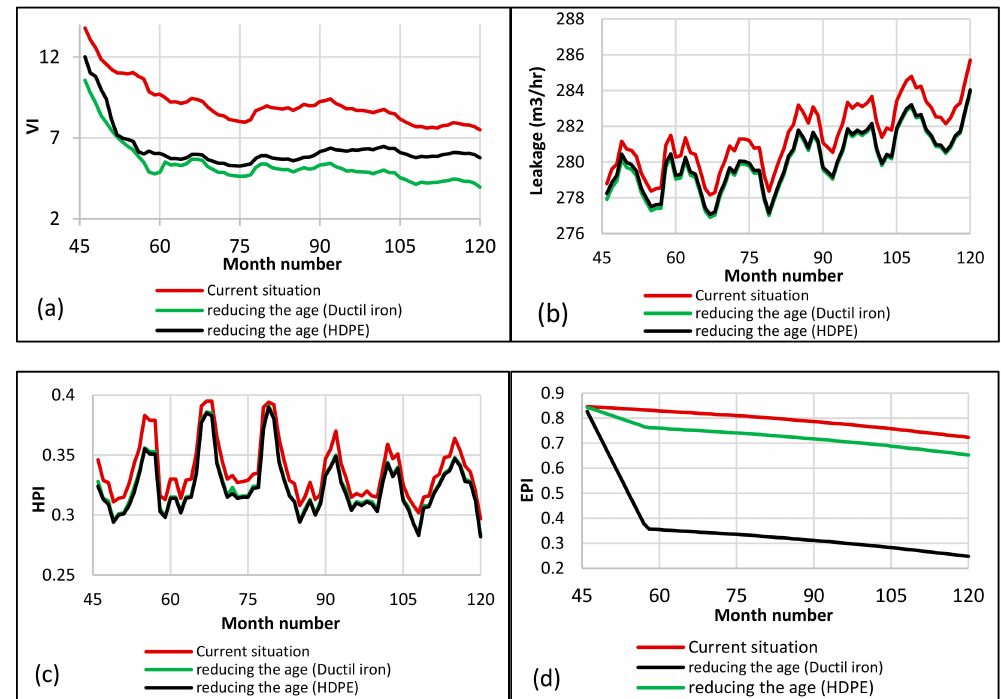
Figure 14. E ff ects of the renewing pipes on: ( a ) VI; ( b ) Leakage; ( c ) HPI; ( d )